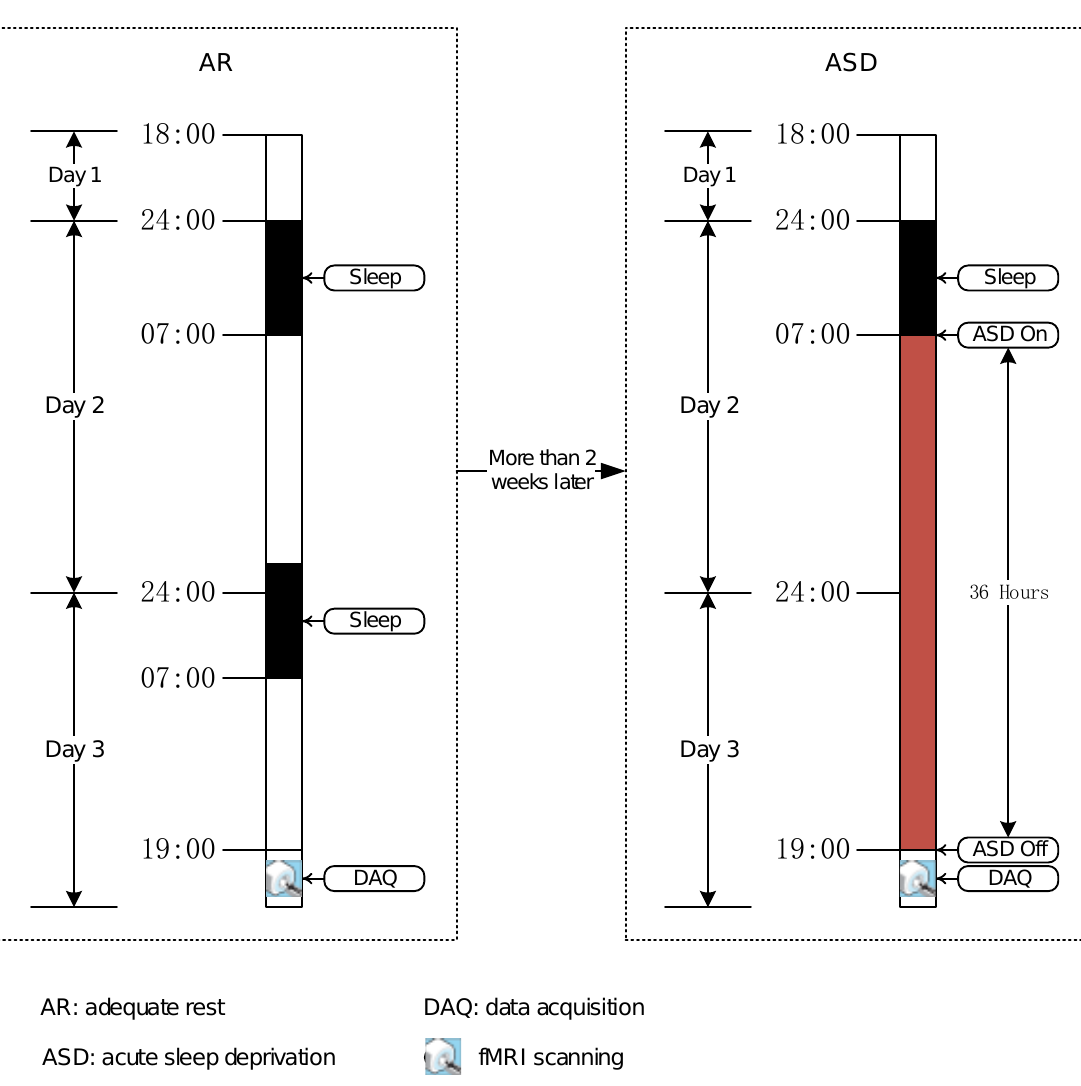
Figure A1. Experimental design and implementation. The participants were scanned twice by the nuclear magnetic resonance spectrometer, and the scans were separated by an interval of more than 2 weeks. During the AR session, participants kept their regular sleep habits and underwent the AR scan from 7:00 P.M. to 8:00 P.M. During the ASD session, participants were required to remain awake and were monitored in the lab from 7:00 A.M. to 7:00 P.M. the next day to make sure that approximately 36 h of total sleep deprivation was accumulated. The two experimental sessions were counterbalanced for all participants who were required to be awake during data